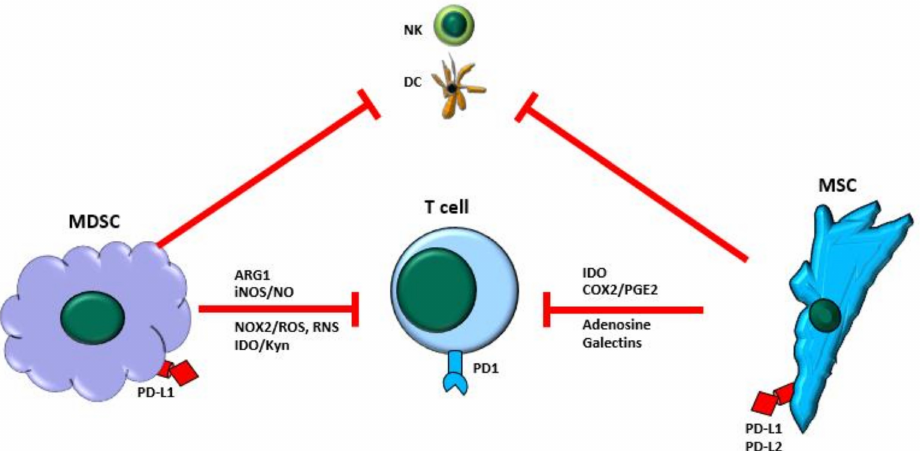
Figure 1. Overview of the immunosuppressive mechanisms of myeloid-derived suppressors cells (MDSCs) and mesenchy- mal stroma/stem cells (MSCs). Both MDSCs and MSCs exert a potent immune-suppressive function on components of the immune system, and they may express and release proteins and molecules that inhibit the activation and function of T lymphocytes (T-cells). In addition, MDSCs and MSCs may target other immune system cellular members such as dendritic cells (DC) and natural killer cells (NK). ARG1, arginase-1; iNOS, inducible nitric oxide synthase; NO, nitric oxide; COX2, cyclooxygenase-2; PGE2, prostaglandin-2; NOX2, NADPH oxidase-2; ROS, reactive oxygen species; RNS, reactive nitrogen species; IDO, indoleamine 2,3-dioxygenase; Kyn, kynurenine; PD1, programmed death-1; PD-L1, PD-L2, programmed death-ligand 1, -ligand